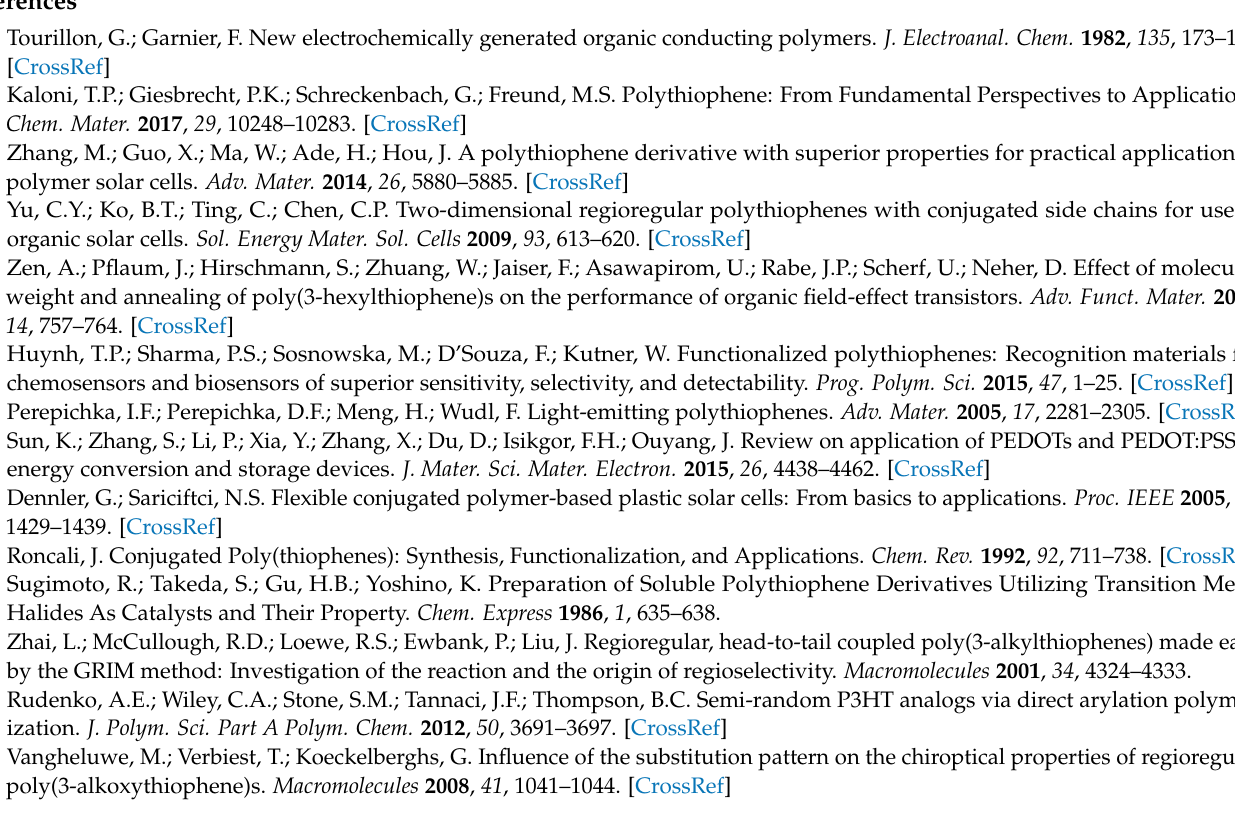
spectrum of EDOT-C12, Figure S4: GPC calibration curve, Figure S5: GPC elugrams for PEDOT-C12, Figure S6: GPC elugrams for PBHOT, Figure S7: GPC elugrams for